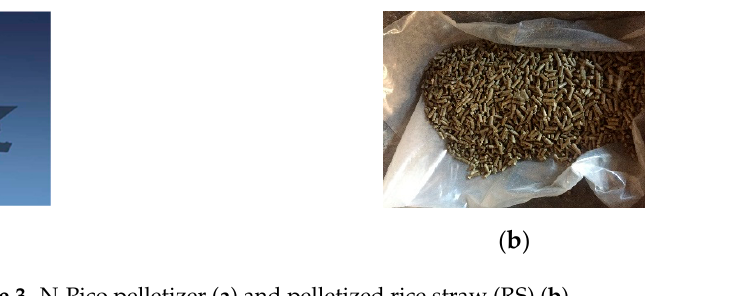
Figure 2. Pellets produced using the single press.